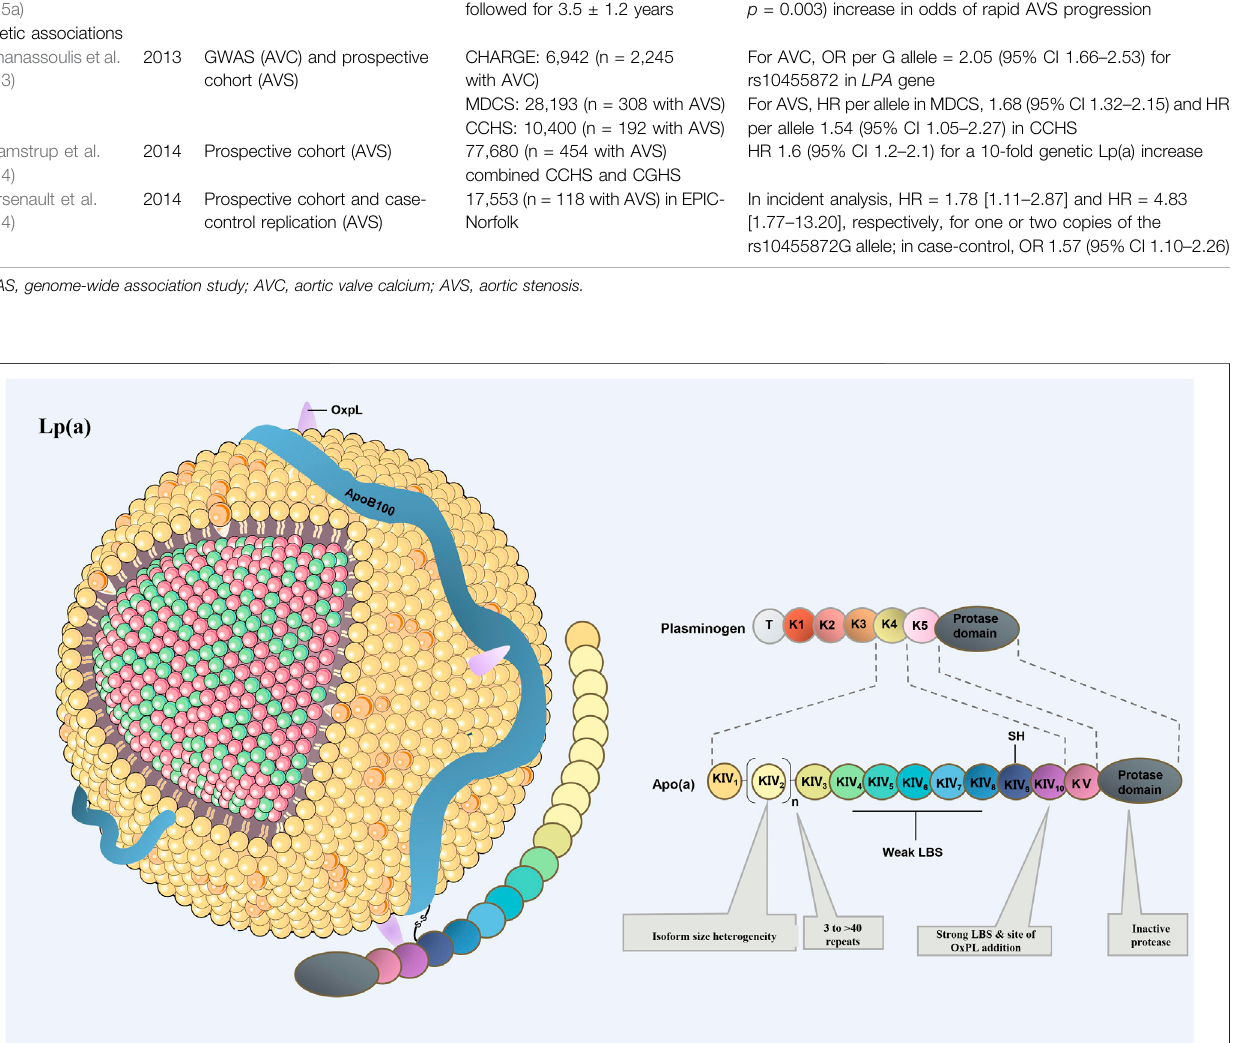
Frontiers in Cell and Developmental Biology |